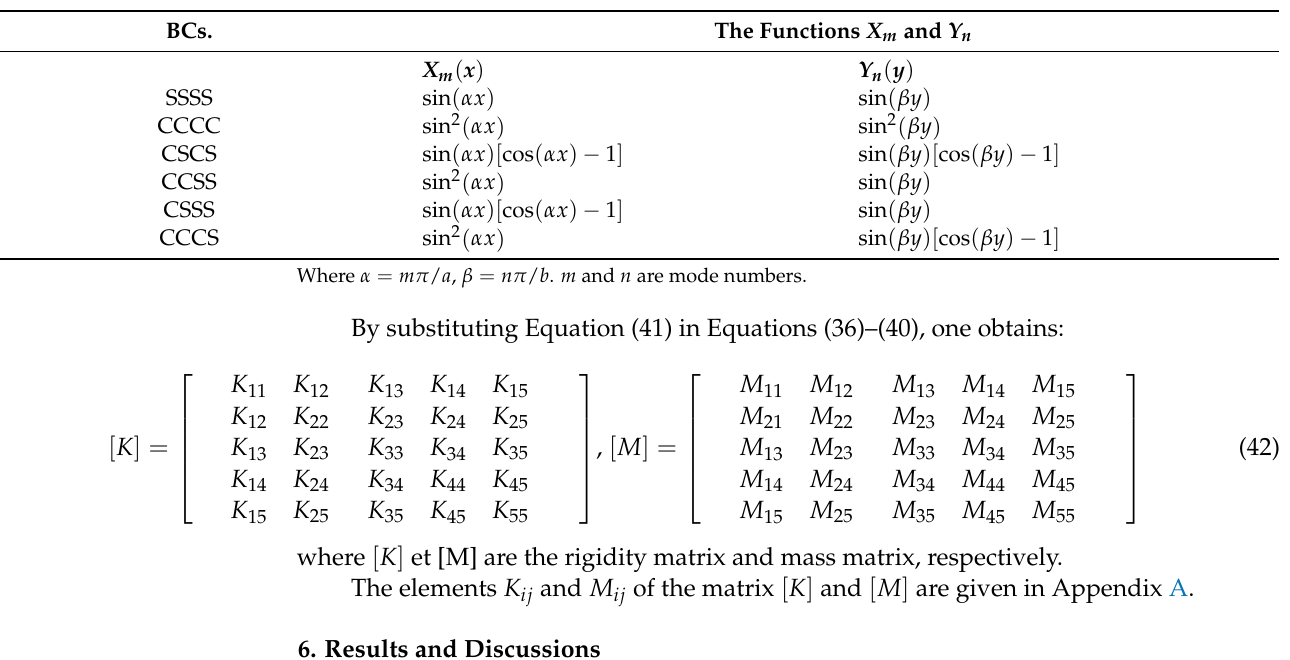
Table 3. The admissible functions X m ( x ) and Y n ( y ) .